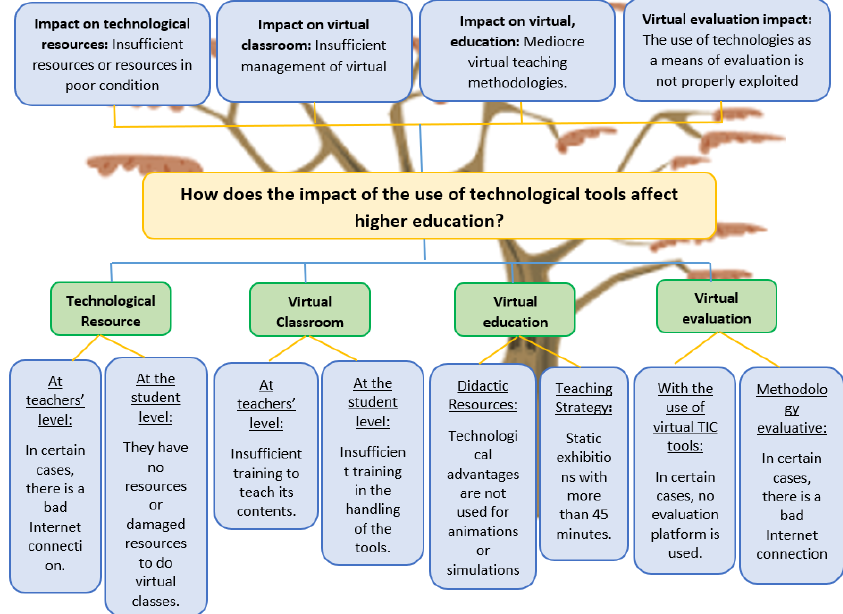
Fig. 1. Problem tree to analyze the impact and consequences of using technology tools in higher